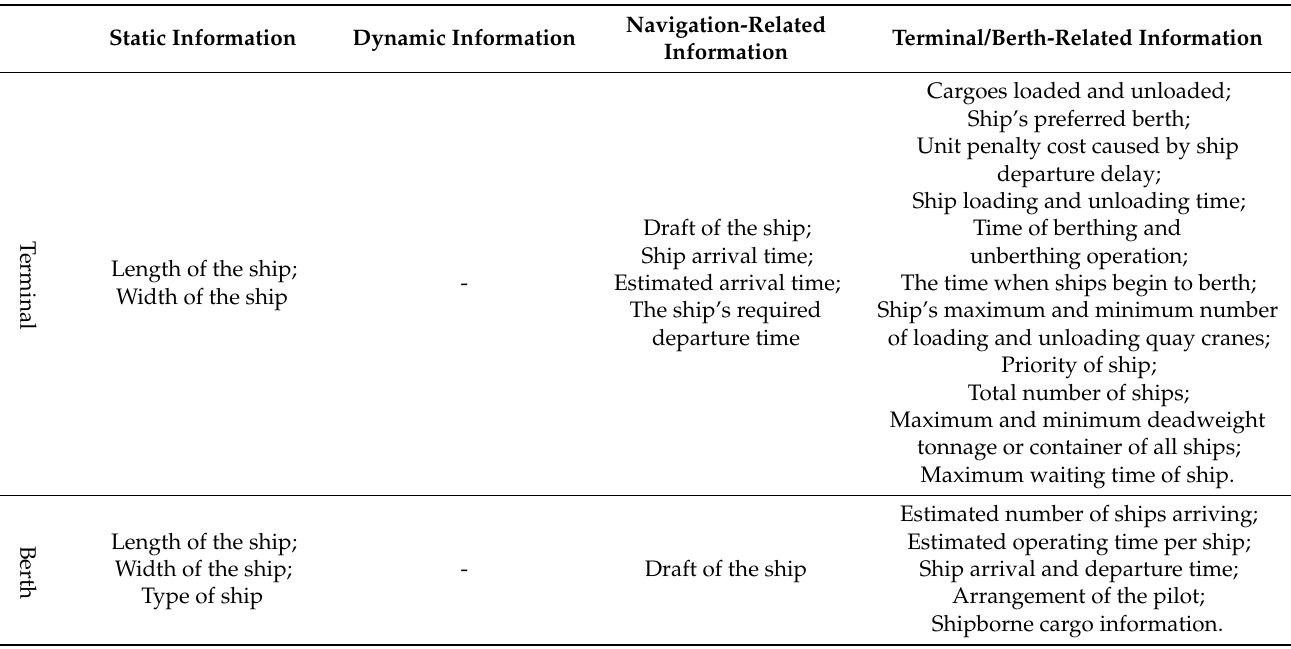
Table 4. Information in the terminal/berth scheduling